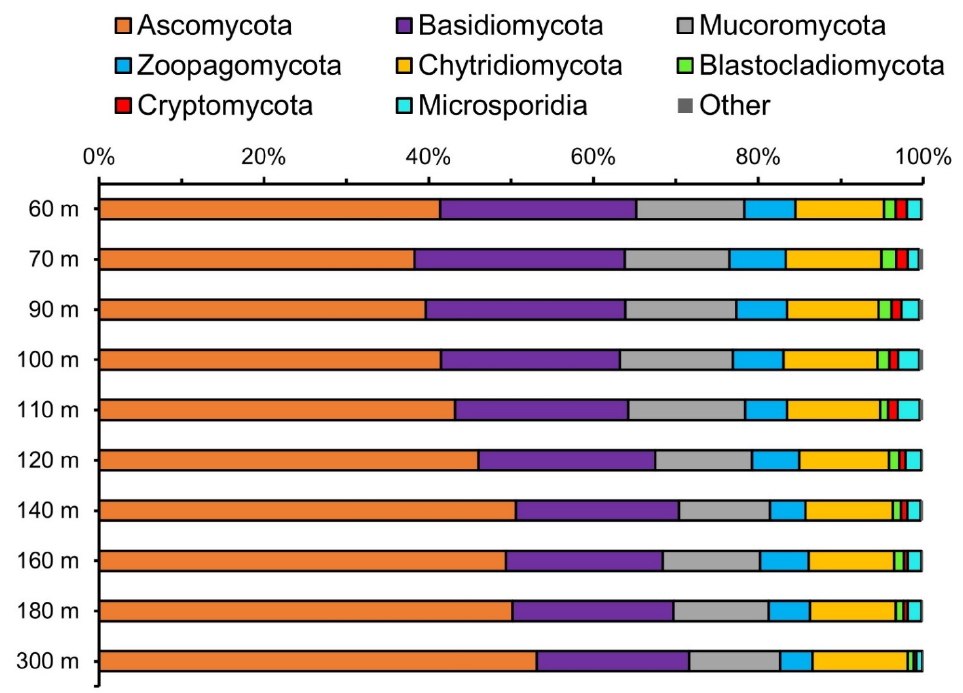
Figure 3. The relative abundance of each fungal phylum identified in the metagenomes [37] collected from a location near Station 2 in this study.